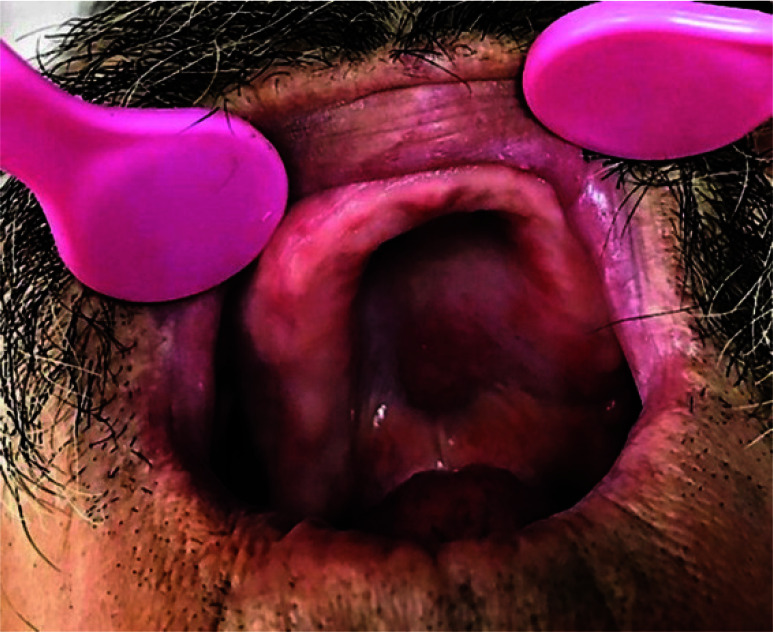
 Erythema before treatment with nystatin